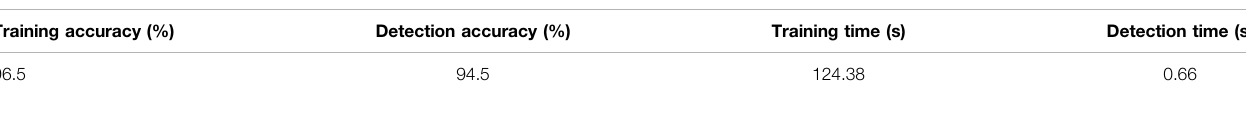
TABLE 2 | BDD performance of the semi-AAE method on the IEEE 14-bus system. Training accuracy